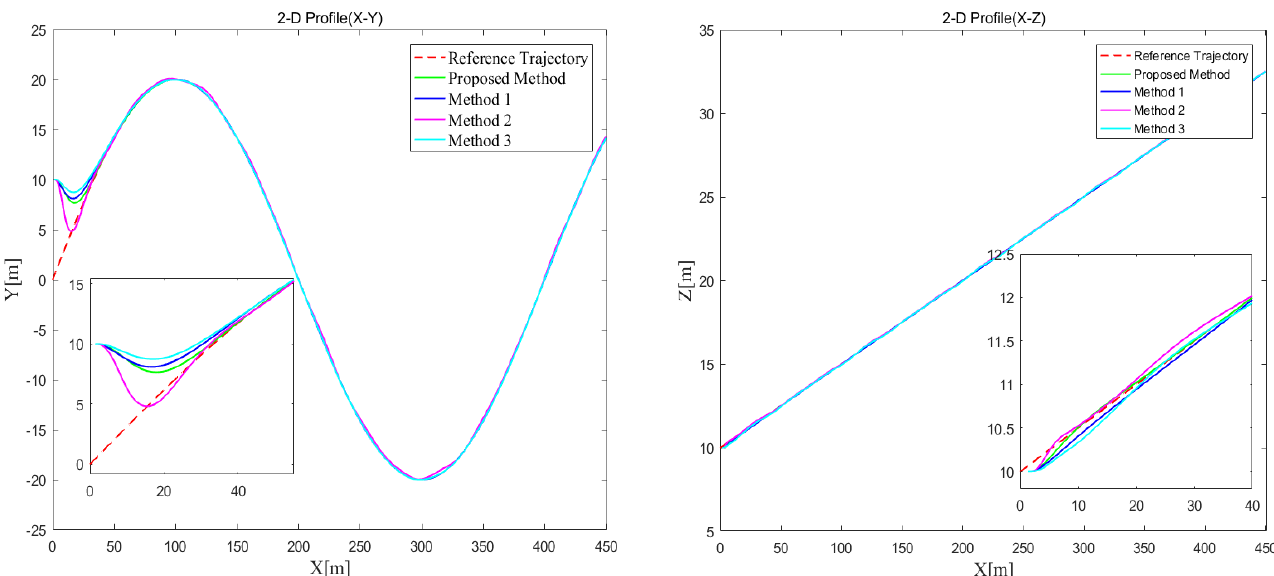
Figure 10. 2D profile comparison of Case 2.